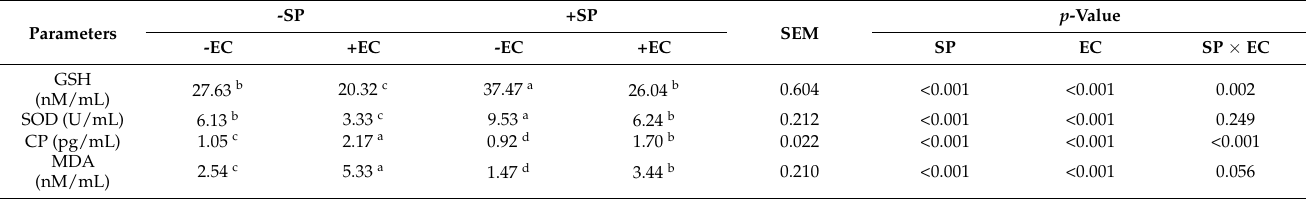
Table 4. Effect of dietary Spirulina platensisis (SP) supplementation on the antioxidant biomarkers of broilers challenged by Escherichia coli (EC) infection.